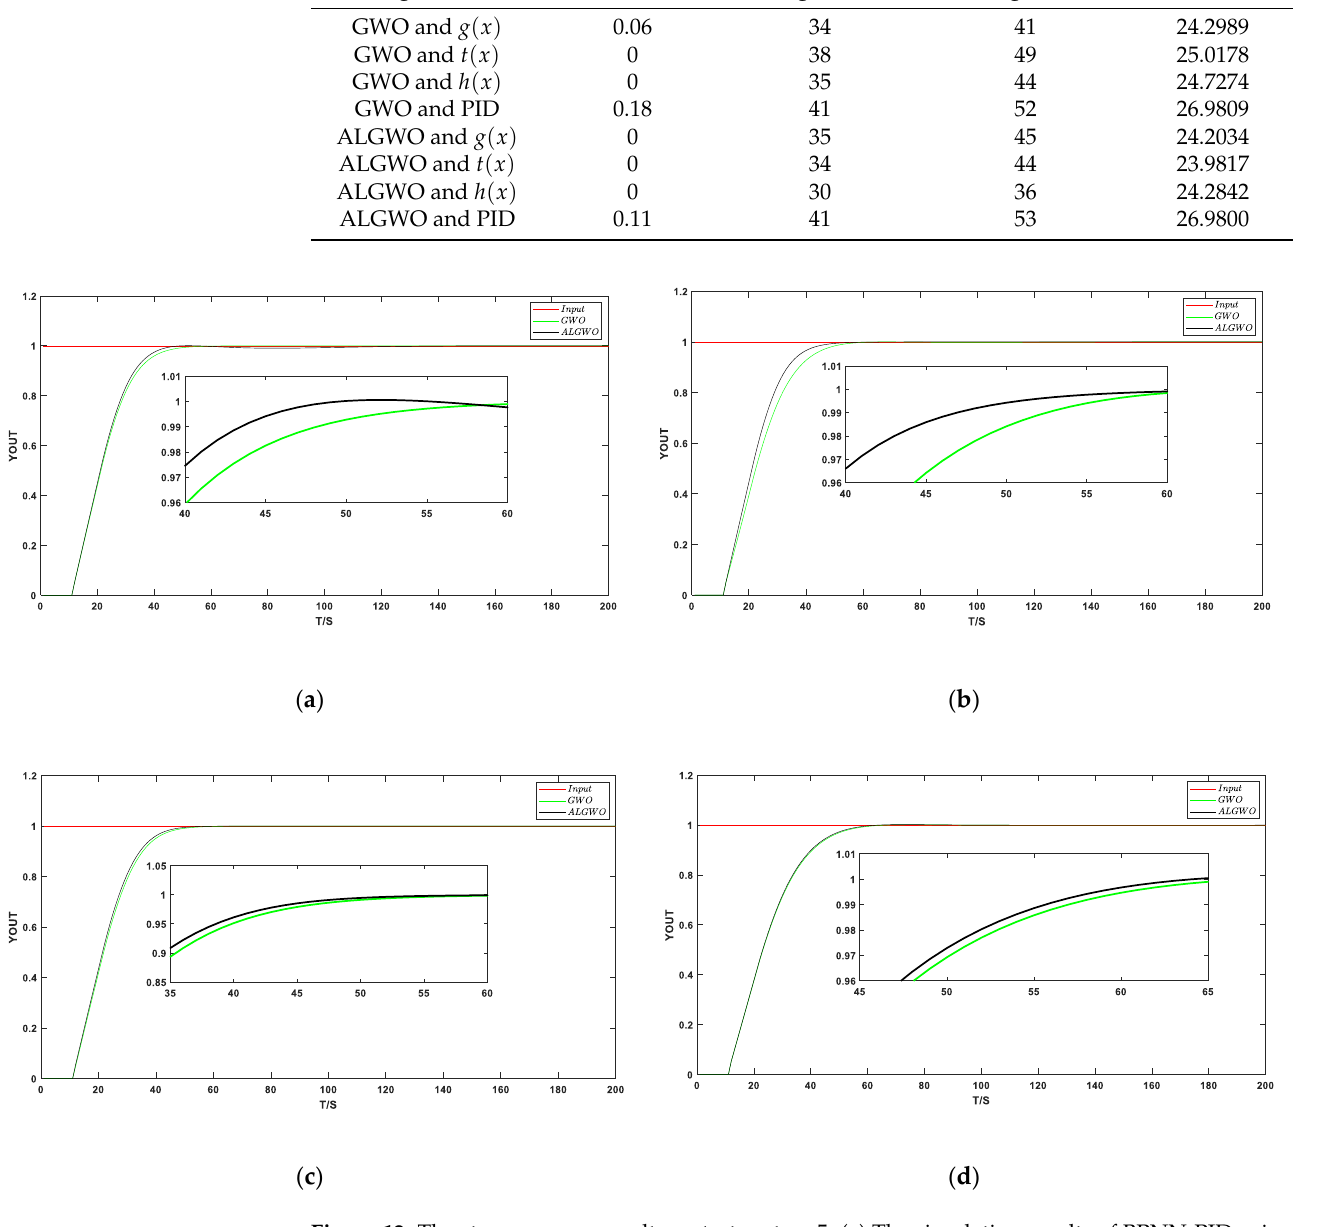
g ( x ) and ( b ) simulation results of BPNN-PID using t ( x ) and ( c ) simulation results of BPNN-PID using